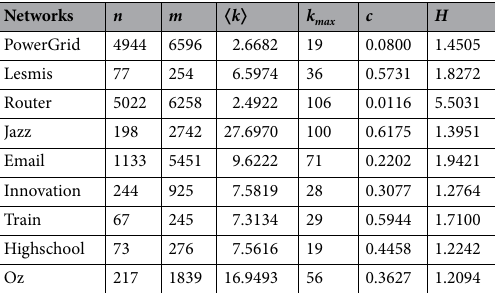
Table 1. The basic topological features of nine real networks. n and m are the total number of nodes and edges, respectively. 〈 k 〉 is the average degree for networks. k max is the maximum degree for networks. 〈 c 〉 is the average clustering coefficient and H is the degree heterogeneity, defined as = H k k 2